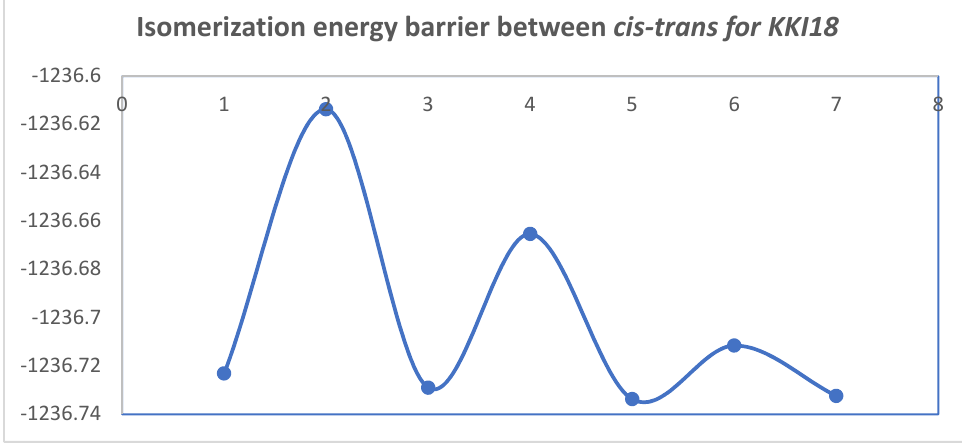
Figure 10. Schematic representation of the isomerization energy barrier between cis-trans.(y = Energy